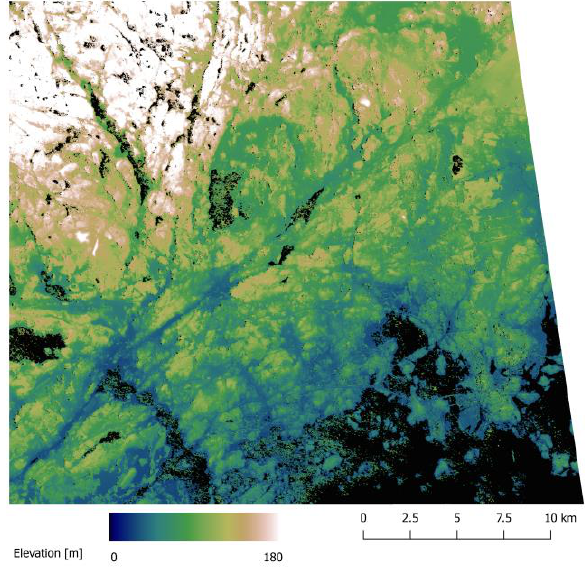
Figure 4: Raw DEM of the whole test area after DEM processing steps, black indicates no data The RMSE of the check points was found to be 3.2 meter.